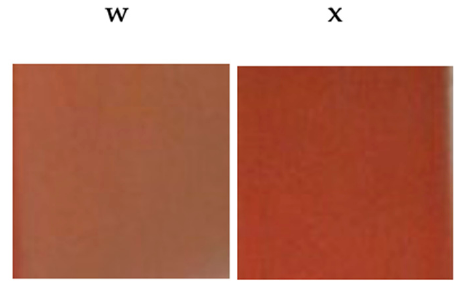
Figure 17. Color development of glazed tiles with pigment Y 0.98 Al 0.98 Cr 0.04 O 3 with flux agent mixture